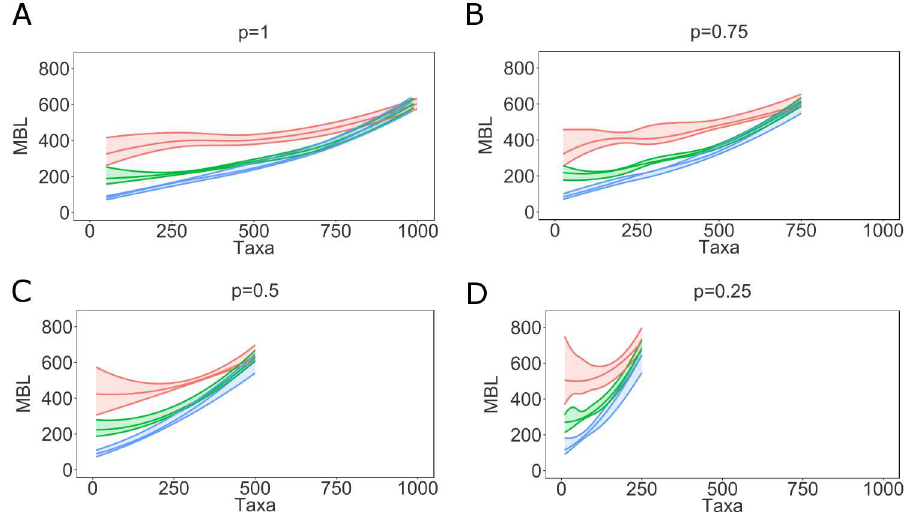
Fig 7. Mean branch length as function of the number of taxa varying sampling fraction. Mean branch length as function of sampledhosts, with varyingsamplingfraction (p = 1-0.25). The envelopes represent 95% confidenceintervals aroundthe medians.The curves are obtainedusing local regression(LOESS). Note that for smaller samplingfractions the envelopes includefewer taxa. WS ( red ), ER ( green ),BA ( blue ).